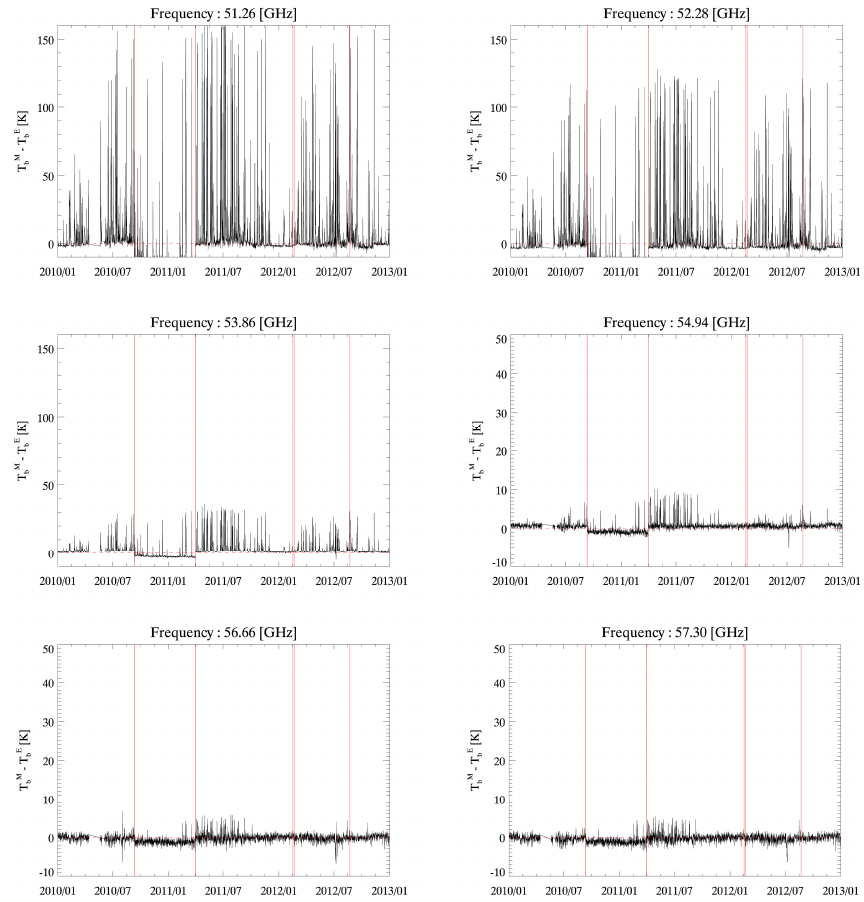
Figure 4. Time series of the difference between the T M bars denote the date when the absolute calibration is